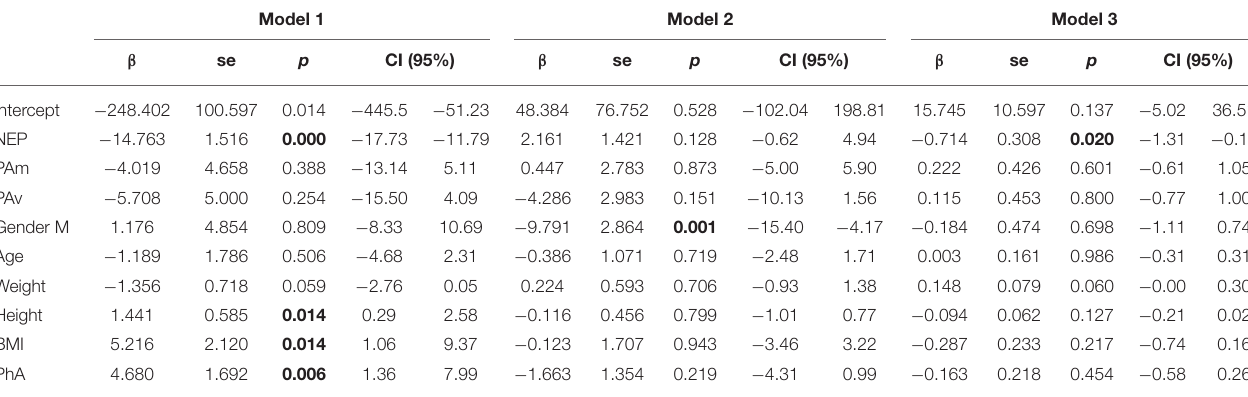
TABLE 5 | Mixed-effect linear regression model for the association between ferritin, ESR, CRP, and NEP, PA, and a set of anthropometric parameters, considering T0 and T1 as a unique longitudinal dataset. Model 1 Model 2 Model